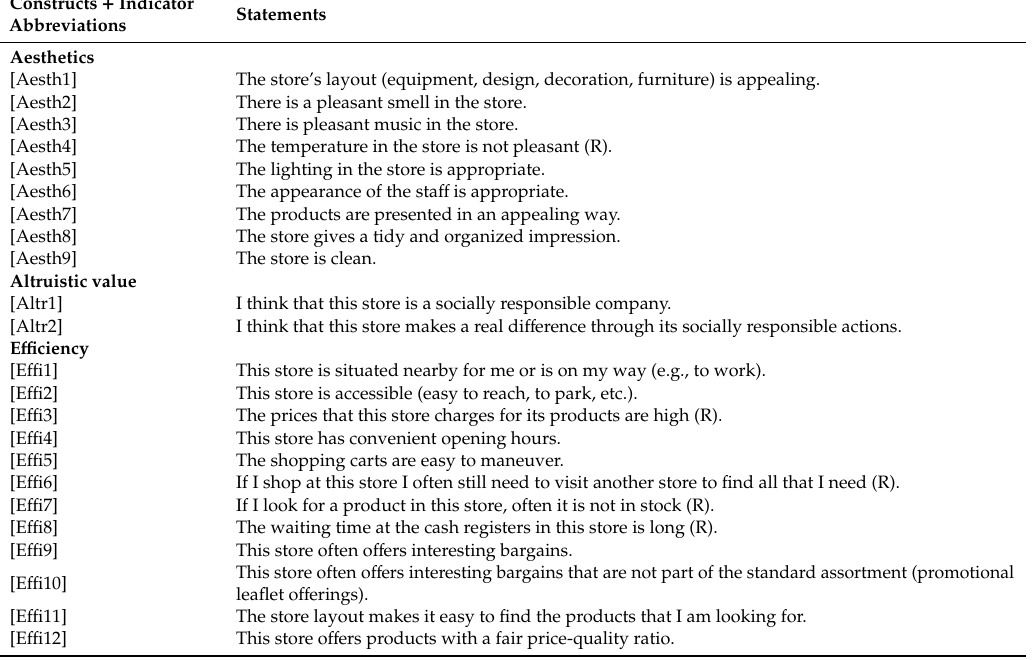
Table A1. Statements Used to Measure Customer Values and Consumer Behavior